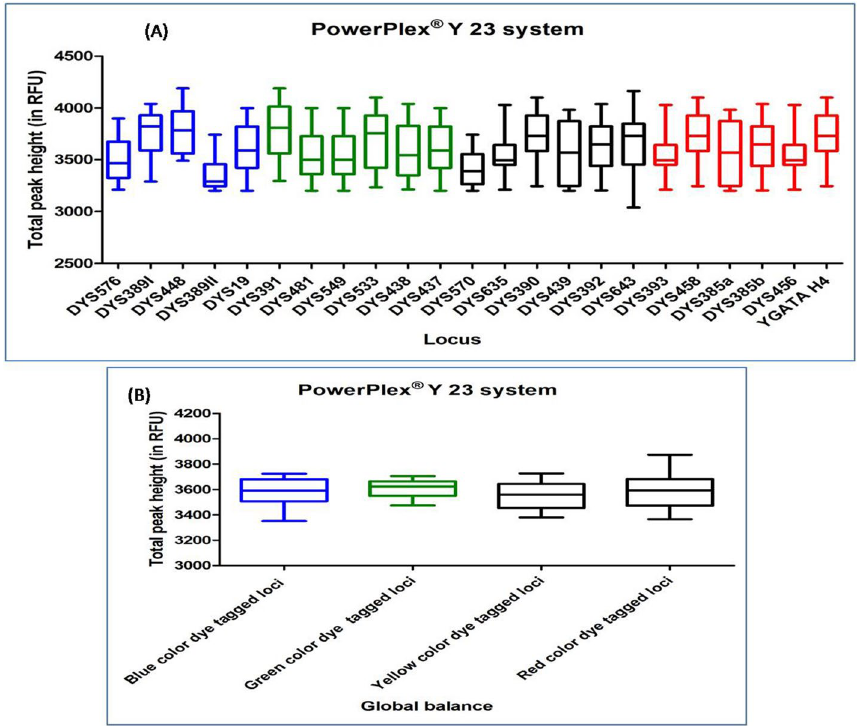
Figure 11. Quality assessment of DNA profile by Dunn’s multiple comparison test for the POWERPLEX Y 23 SYSTEM ( A ) Total peak height ( B ) Global balance.